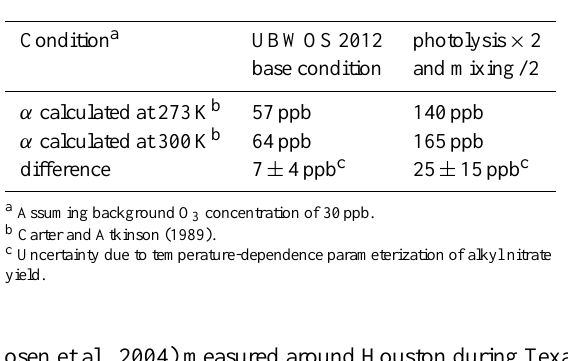
Table 3. Expected maximum O x (NO 2 + O 3 ) concentration under UBWOS conditions.